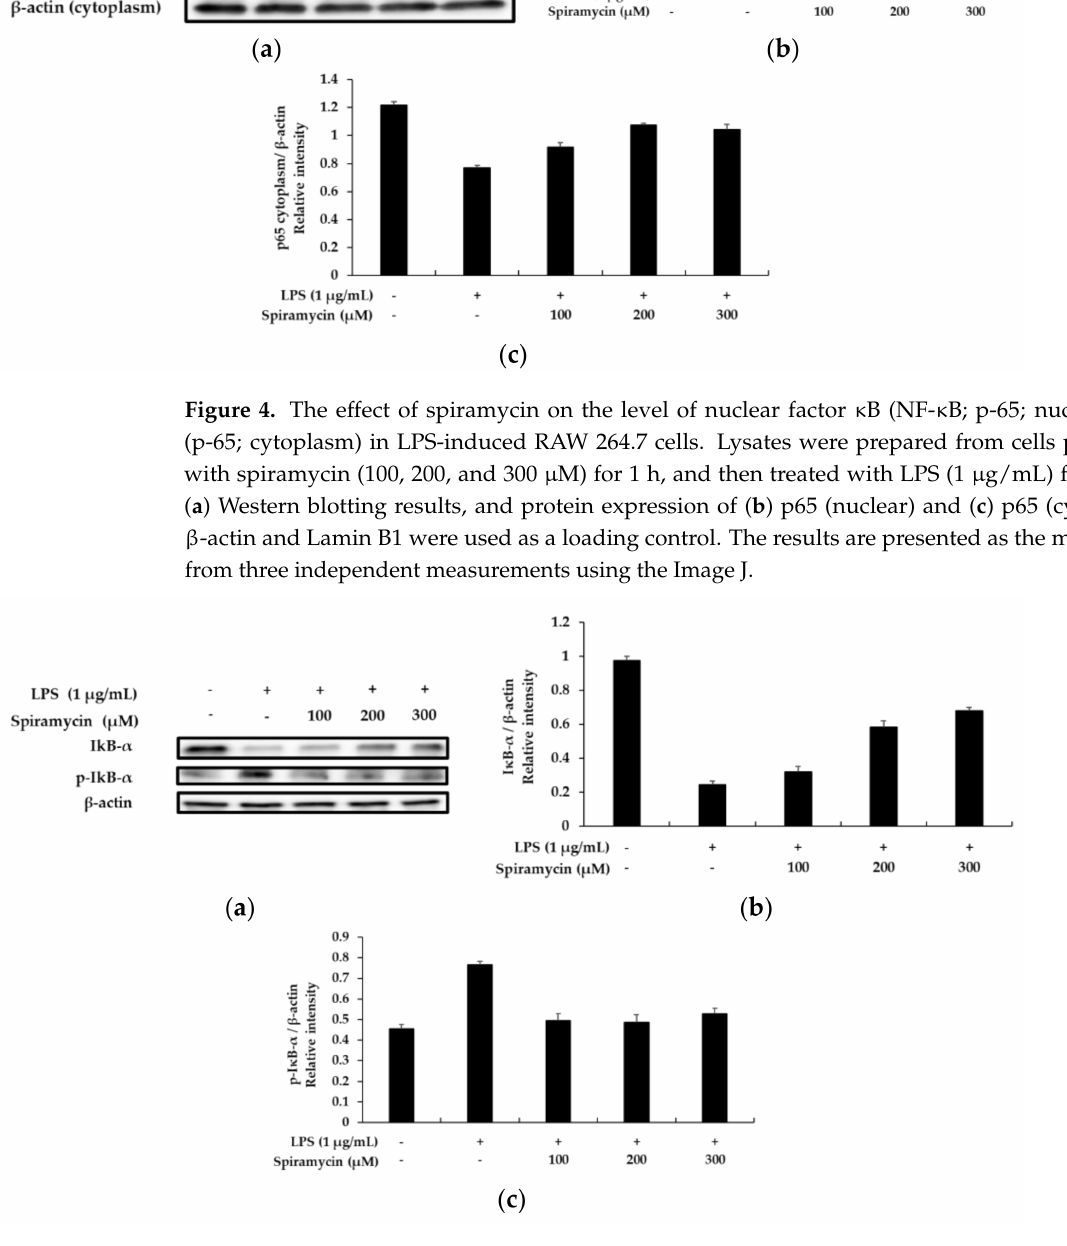
Figure 5. The effect of spiramycin on the levels of phospho-I κ B- α and I κ B- α in the LPS-induced RAW 264.7 cells. Lysates were prepared from cells pretreated with spiramycin (100, 200, and 300 µ M) for 1 h, and then treated with LPS (1 µ g/mL) for 20 min. ( a ) Western blotting results, and protein expression of ( b ) I κ B α and ( c ) P-I κ B α . β -actin was used as a loading control. The results are presented as the mean ± SD from three independent measurements using the Image J. β -actin was used as a loading